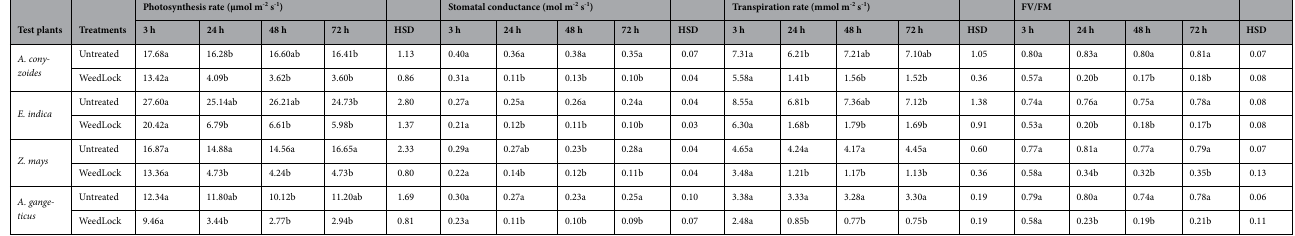
Table 1. Effect of WeedLock on physiological processes of test plants. Means having different letters differ significantly at p < 0.05.